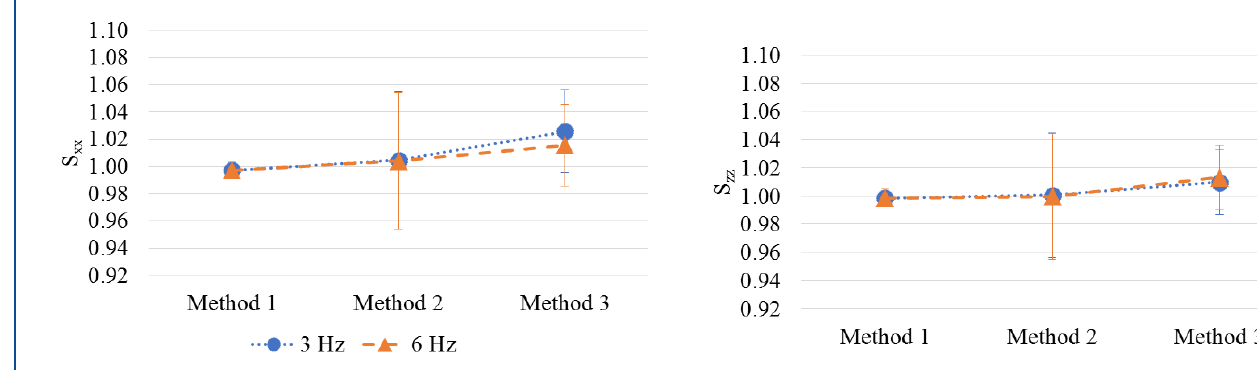
Figure 16. MEMS accelerometer: comparison between methods (main sensitivity along the x axis, S xx ).